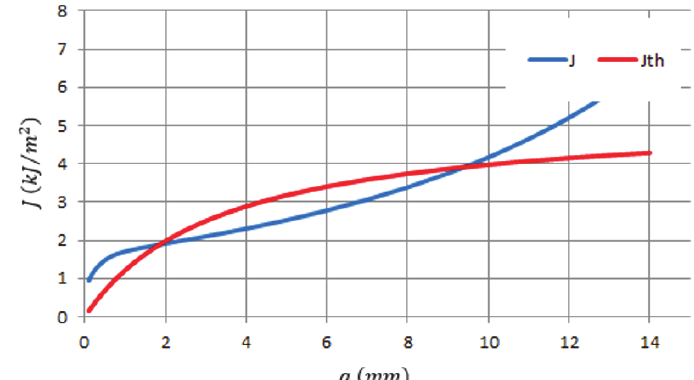
Figure 4: EP crack that starts at a notch tip and then stops after growing for 1.8mm.